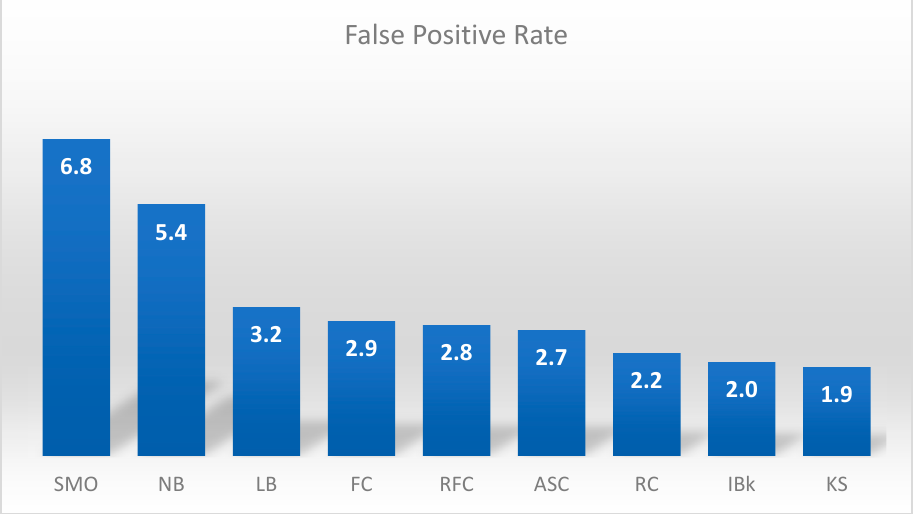
Figure 13. Comparison of classifiers’ performance (grouped into the performance metrics).